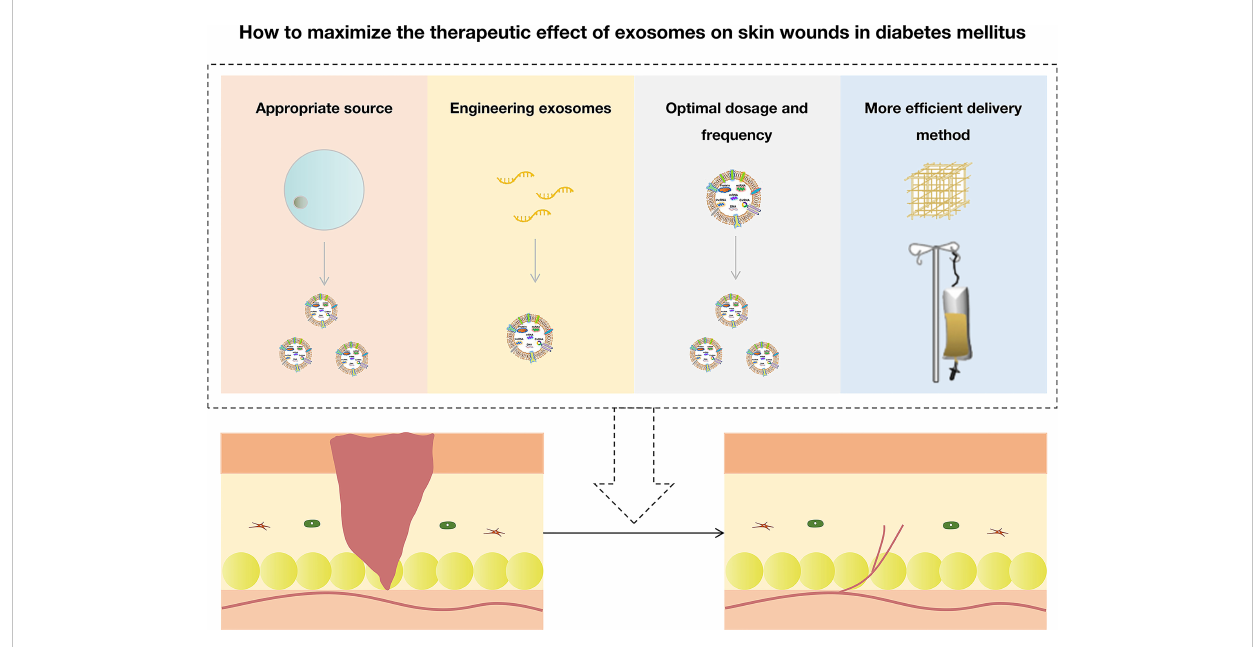
FIGURE 5 How to maximize the therapeutic effect of exosomes on skin wounds in diabetes